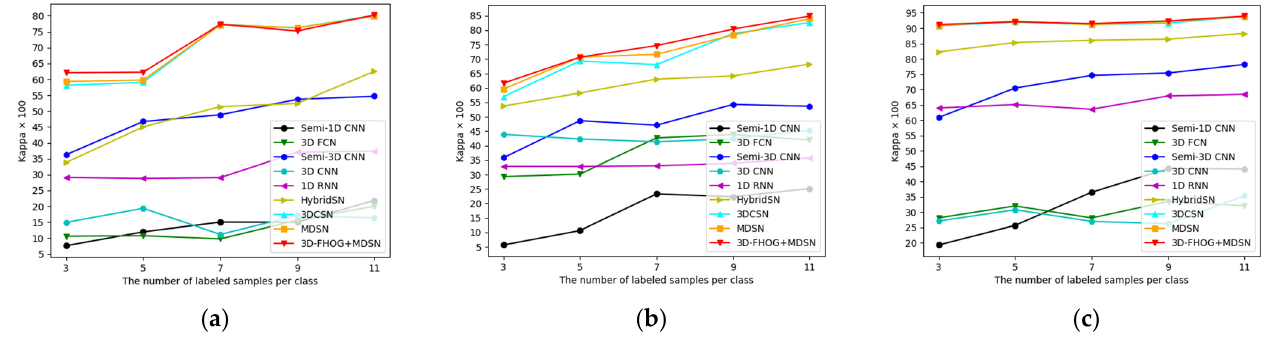
Figure 12. Kappa coefficient as functions of the number of labeled samples per class on three test data sets: ( a ) IP data set; ( b ) PU data set; ( c ) SA data set.